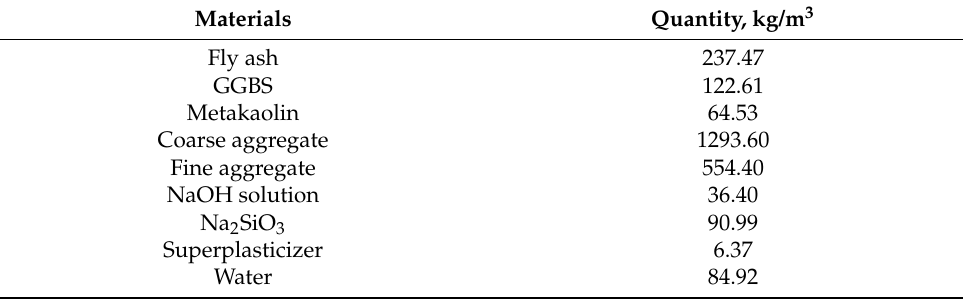
Table 1. Mix proportion of ternary blend geopolymer concrete.